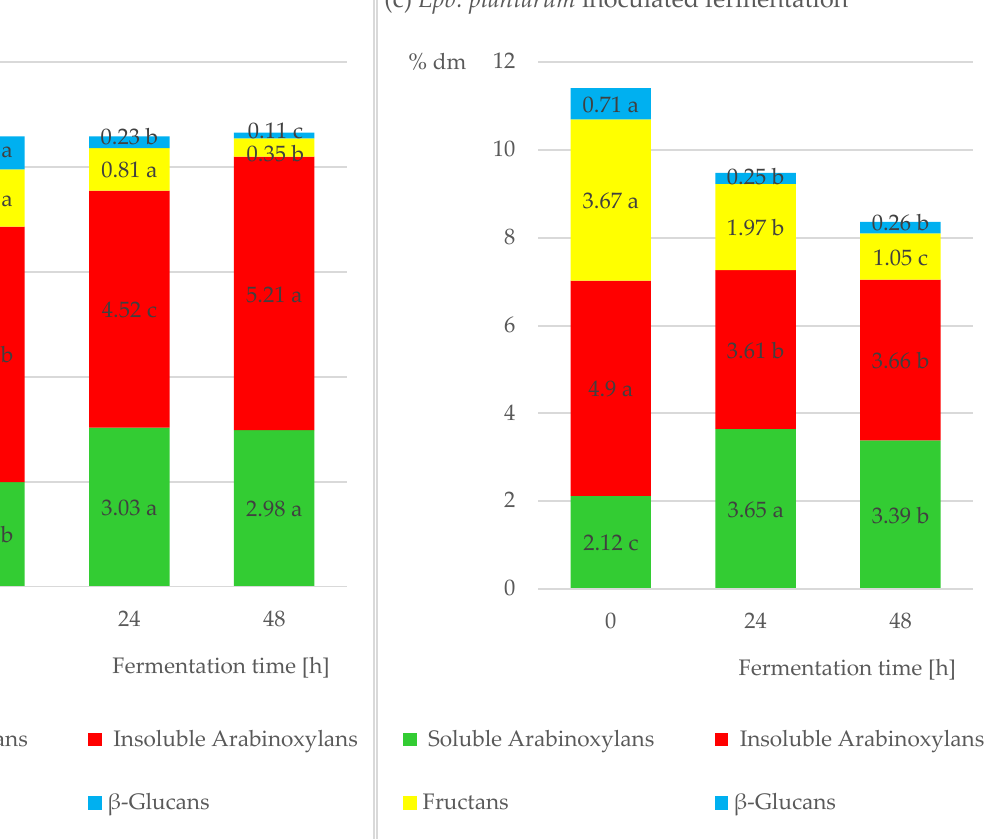
Values represent the means of two replicates. Lowercase letters indicate homogeneous groups determined using the Duncan test. Figure 1. Cont